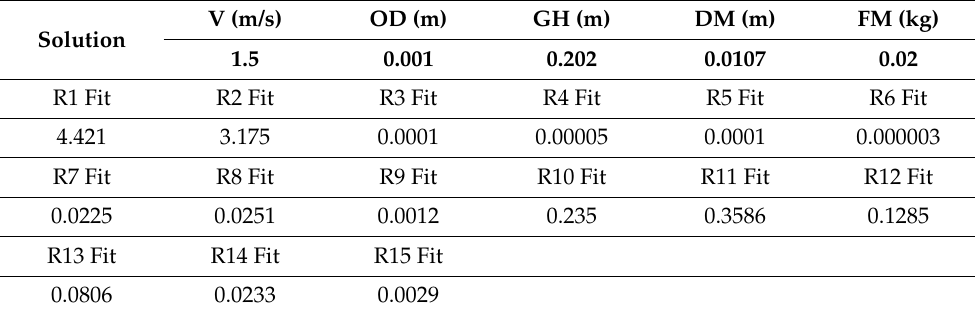
Table 4. Optimum conditions and simulated fitted responses with composite desirability of